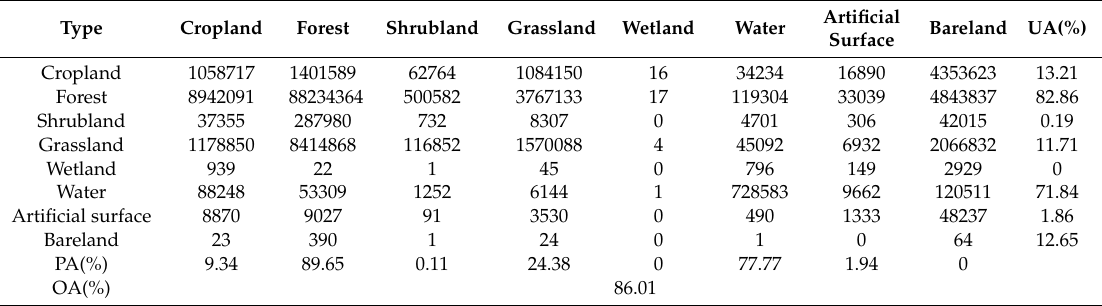
Table 5. Confusion matrix of FROM-GLC2010 and Globeland30-2010 (FROM-GLC2010 is reference data, Globeland30-2010 is data to be evaluated).